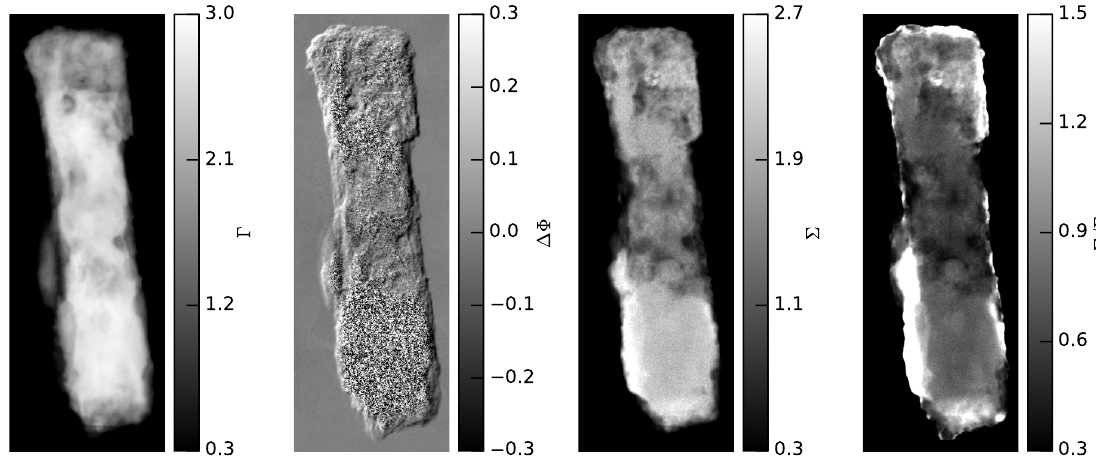
Figure 9. From left to right: Attenuation, differential phase, dark-field and normalised scatter image of the strap-end from Figure 3, acquired at 60kVp and 60mAs per